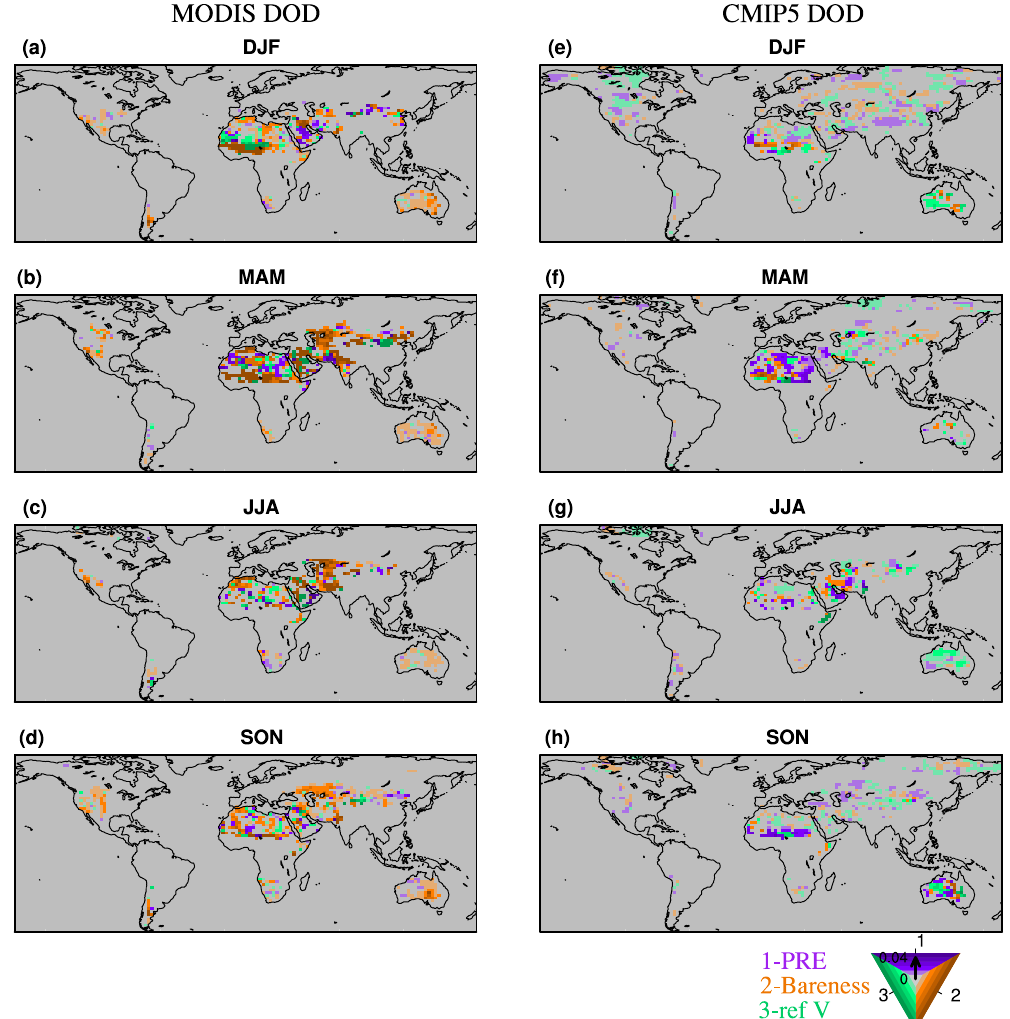
Figure 6. Regression coefficients calculated by regressing DOD in each season onto standardized precipitation (purple), bareness (orange), and surface wind speed (green) from 2004 to 2016. Coefficients obtained using MODIS DOD and observed controlling factors (interpolated to a 2 ◦ by 2.5 ◦ grid) and those using CMIP5 multi-model mean DOD and controlling factors are shown in the left and right columns, respectively. The color of the shading denotes the largest coefficient in absolute value among the three, while the saturation of the color shows the magnitude of the coefficient (from 0 to 0.02). Only regression coefficients significant at the 90% confidence level (bootstrap test) are shown. Missing values are shaded in grey. To highlight coefficients near the source regions, a mask of LAI ≤ 0 . 5 is